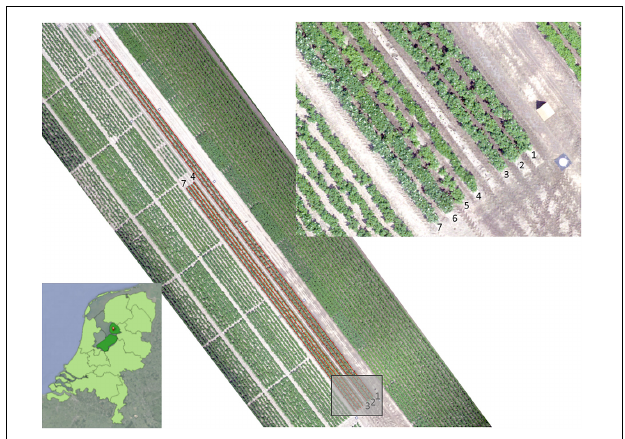
FIGURE 1 | RGB image of the experimental field, acquired with UAV on June 19, 2017. The length of the rows is 110 m for rows 1–3 and 66 m for rows 4–7. The location is near Tollebeek in the Netherlands (lower left).